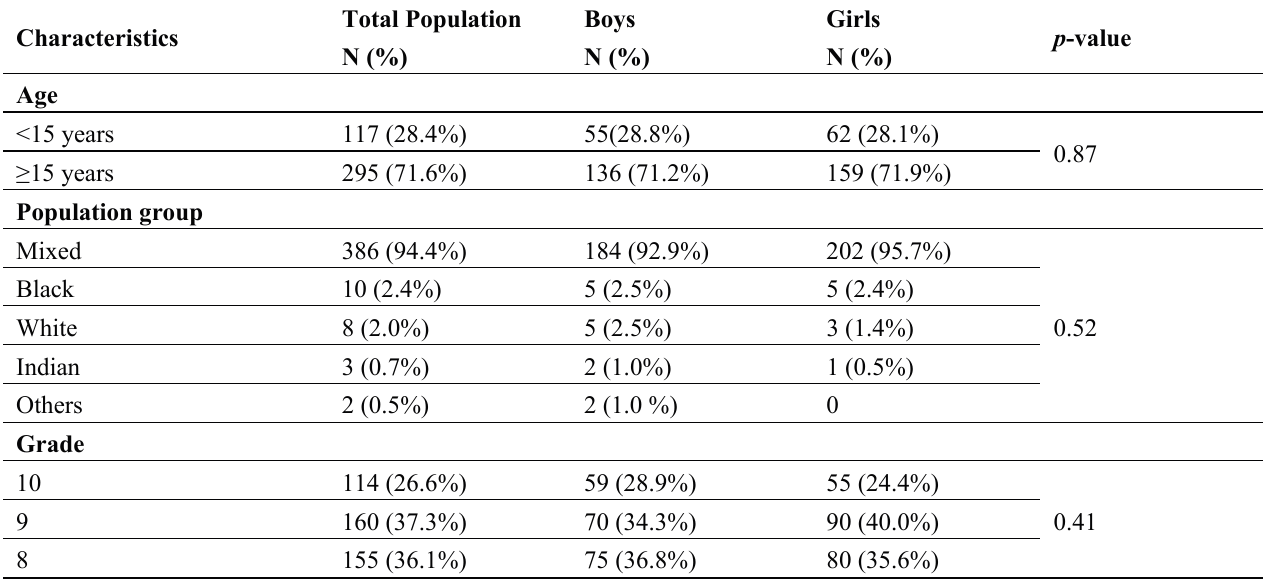
Table 2. Demographic characteristics of study sample (N = 430). SES, socioeconomic